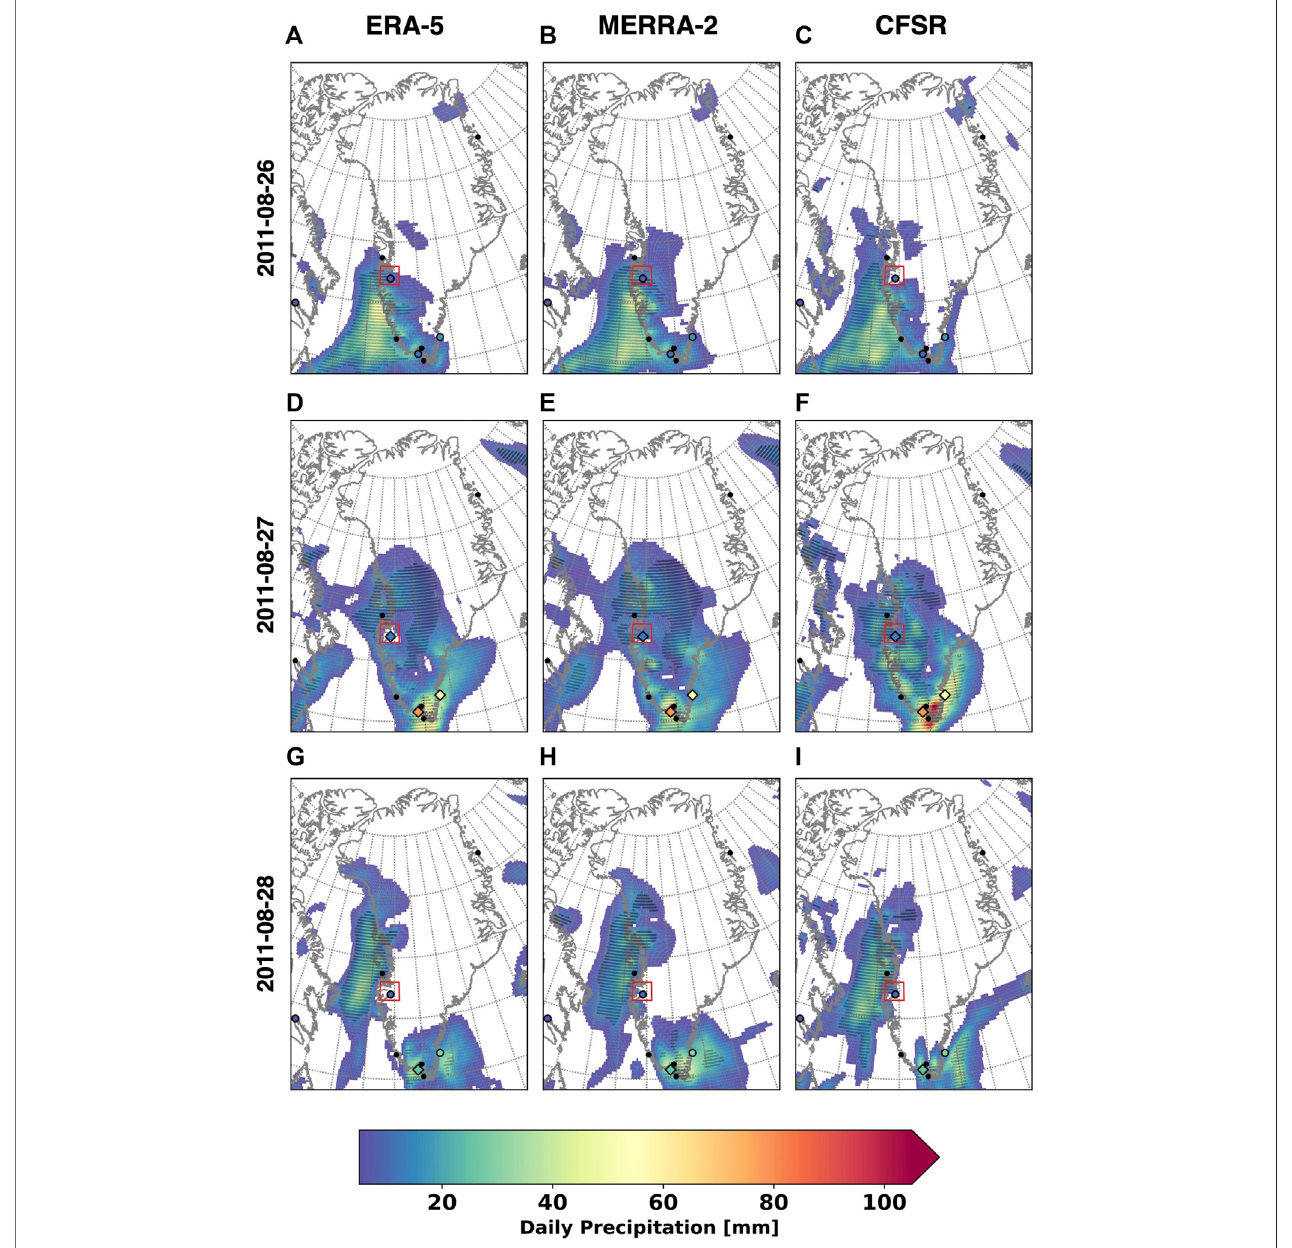
FIGURE 5 | Daily precipitation ( ≥ 5 mm) for 26 – 28 August 2011 from ERA-5 (A,D,G) , MERRA-2 (B,E,H) , and CFSR (C,F,I) . The columns show data for 26 (A – C) , 27 (D – F) ,and28 (G – I) August2011.Stipplingindicatesgridcellswithdailyaccumulationsabovetheextremethreshold.Stationsareshownwithblackdots, fi lledcircles, and fi lled diamonds if no precipitation, non-extreme precipitation, or extreme precipitation were observed, respectively. The color of fi lled station markers indicates the daily precipitation accumulation. The red square highlights the Kangerlussuaq